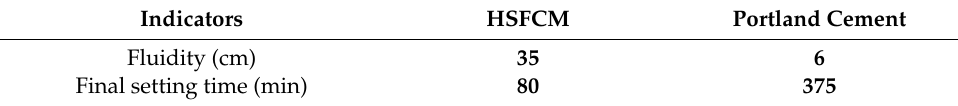
Table 2. Comparison of HSFCM and Portland cement grouting properties.